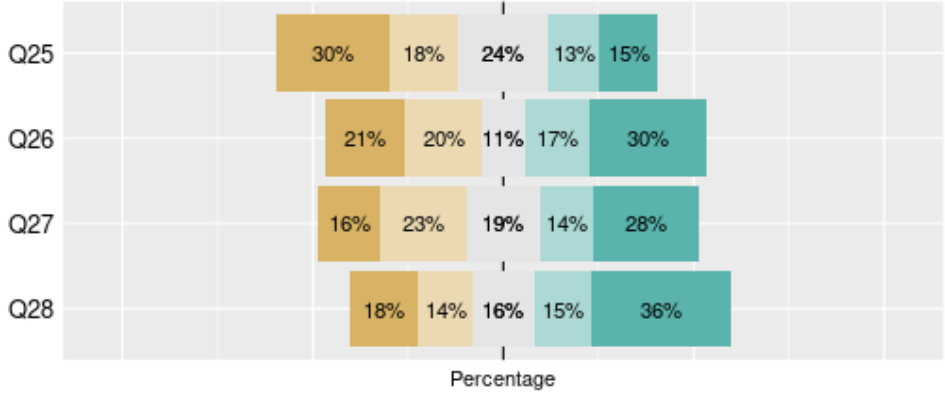
Figure 5. Results related to the Transparency dimension and data holder